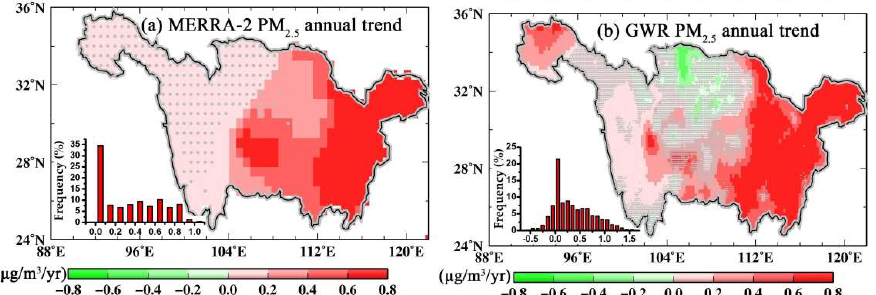
Figure A4. Spatial distribution of PM2.5 annual trend derived form MERRA-2 (a) and GWR (b) over the YRB from 1998 to 2016. Grids marked by grey points represented PM 2.5 trends that did not exceed a 95% significant level. Table A1. Correlation matrix between meteorological variables temperature (T), precipitation (Precip), total cloud cover (Cloud), wind speed (Wind), relative humidity (RH) and Boundary layer height (BLH). * represents p-value < 0.05.